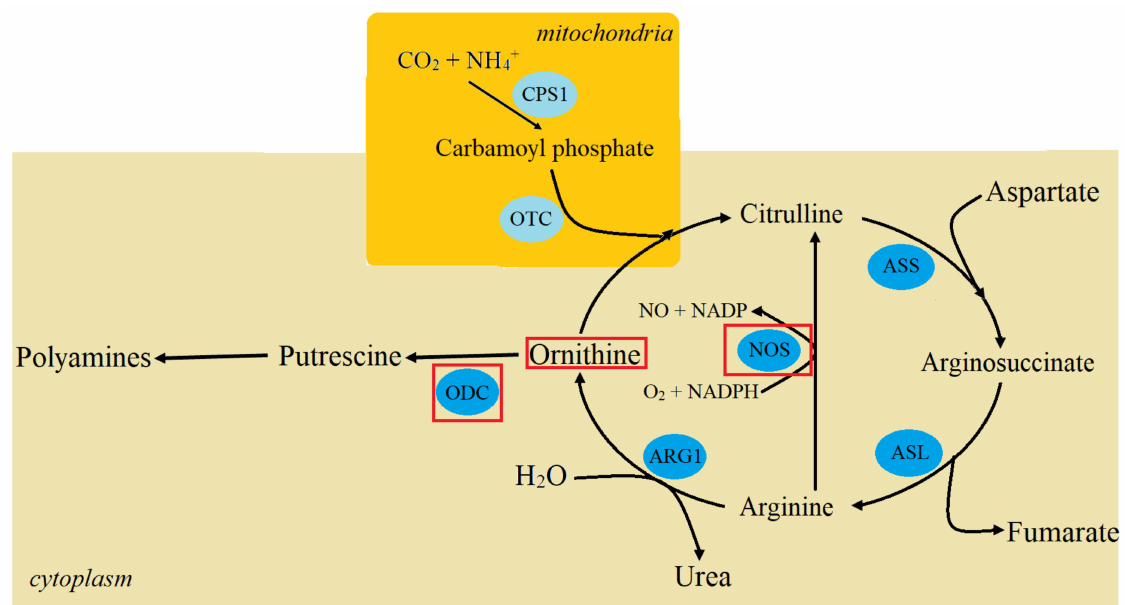
Figure 4. The urea cycle includes five reactions localised at mitochondria of hepatocytes and cytoplasm. The first step involves the CO and ammonia conversion into carbamoyl phosphate via carbamoyl phosphate synthetase I (CPS I). Carbamoyl phosphate and ornithine (whose elevated plasma level and decreased urine level are observed in patients with nephrolithiasis) combine to citrulline via ornithine transcarbamoylase (OTC). Then ornithine translocase transports citrulline from hepatocyte mitochondria into the cytoplasm. Citrulline reacts with aspartate and argininosuccinate forms. This reaction is catalysed by argininosuccinate synthetase (ASS). Argininosuccinate is converted into arginine via argininosuccinate lyase (ASL). Finally, arginase (ARG1) hydrolyses arginine into urea and ornithine. On the other hand, L-arginine may be oxidatively degraded by NOS into L-citrulline and nitric oxide (NO). In the course of nephrolithiasis, a decrease in eNOS expression has been observed. Moreover, ornithine from the urea cycle may be converted by ornithine decarboxylase (ODC) in the polyamine biosynthetic pathway. ODC polymorphism may be associated with an increased risk of kidney stones